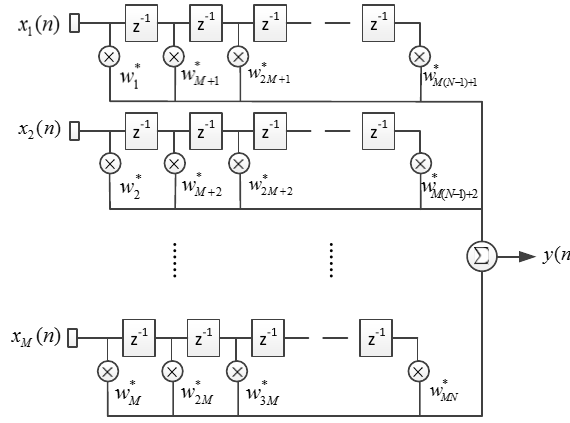
Figure 3. The architecture of a spatial-time adaptive processor (STAP).